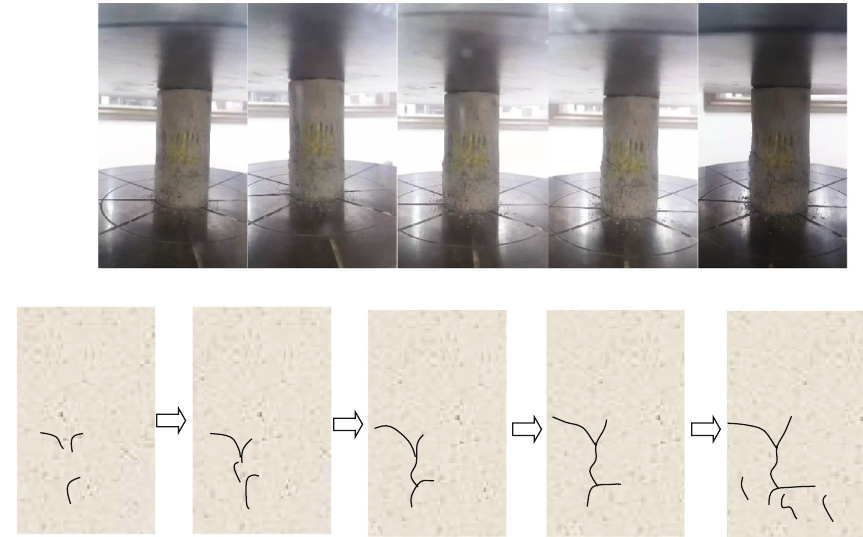
Figure 7: Damage process of back fi